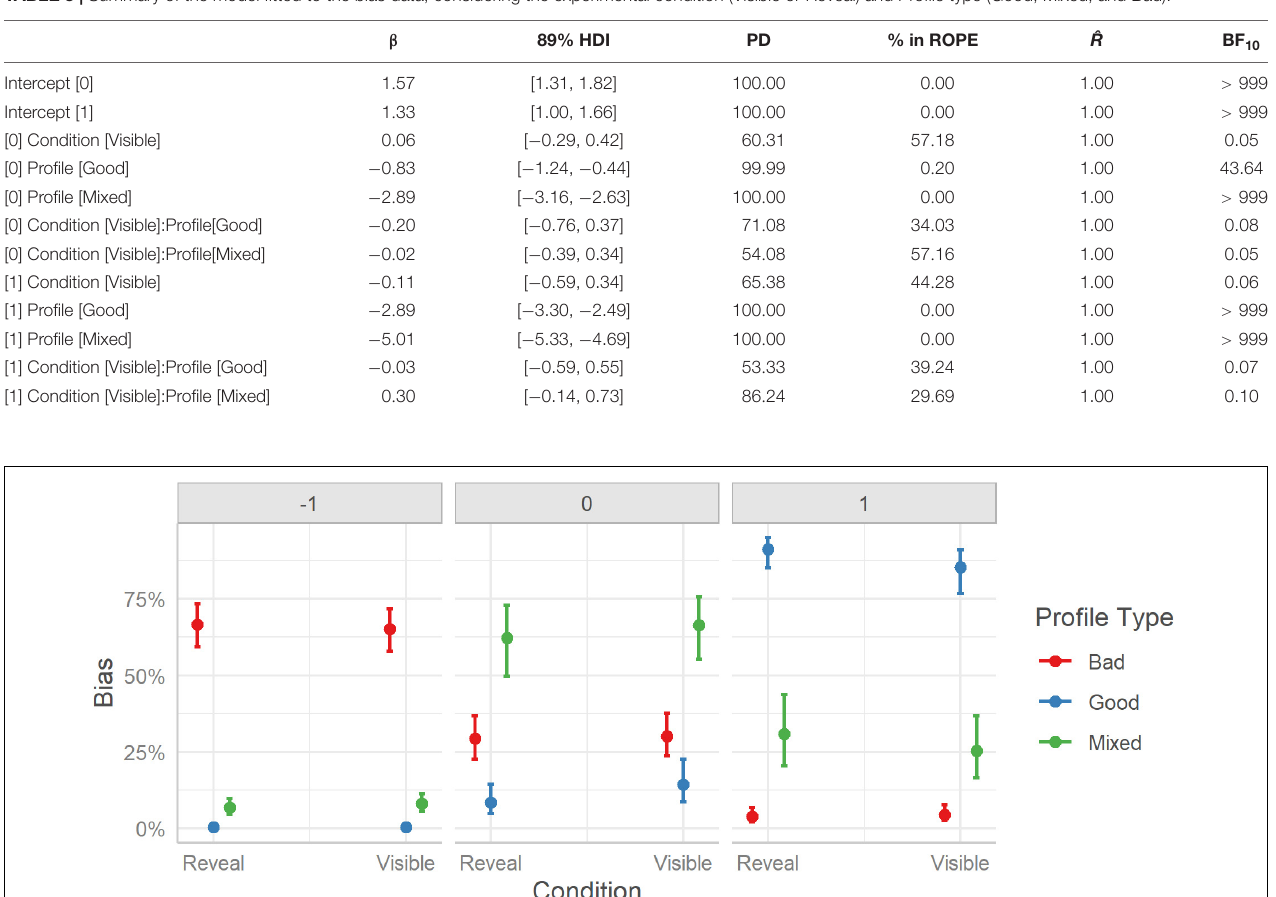
Frontiers in Psychology |